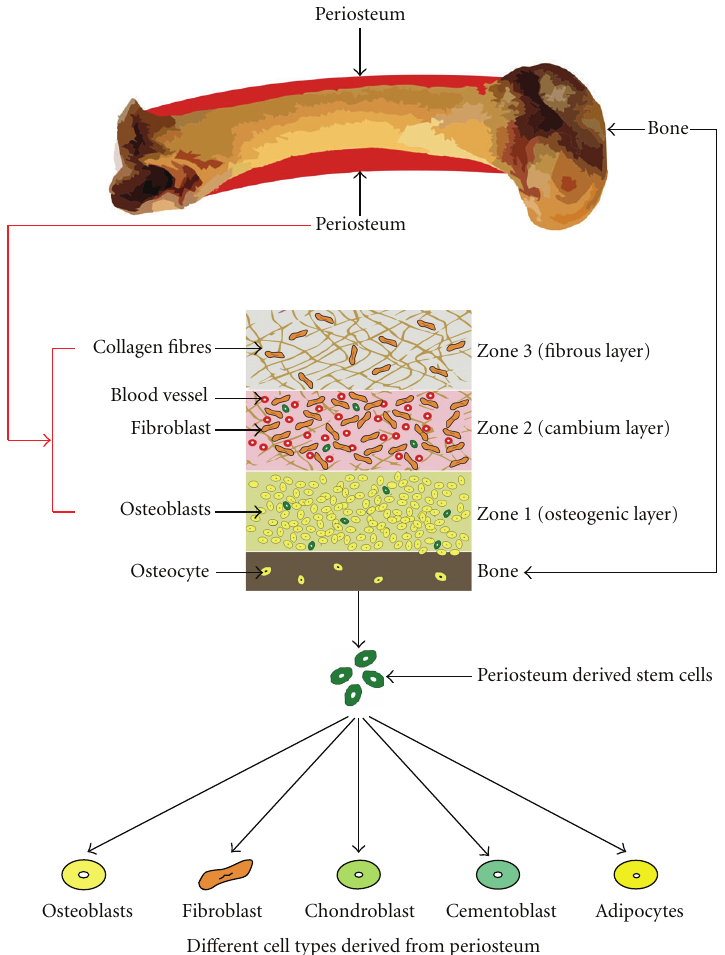
Figure 2: The three di ff erent Zones of periosteum; Zone 1 has an average thickness of 10–20 um consisting predominantly of osteoblasts; the majority of cells in Zone 2 are fibroblasts, with endothelial cells being most of the remainder. Zone 3 has the highest volume of collagen fibrils among all the three zones. The bottom of the figure shows regenerative capacity of the periosteum to form di ff erent cell types.